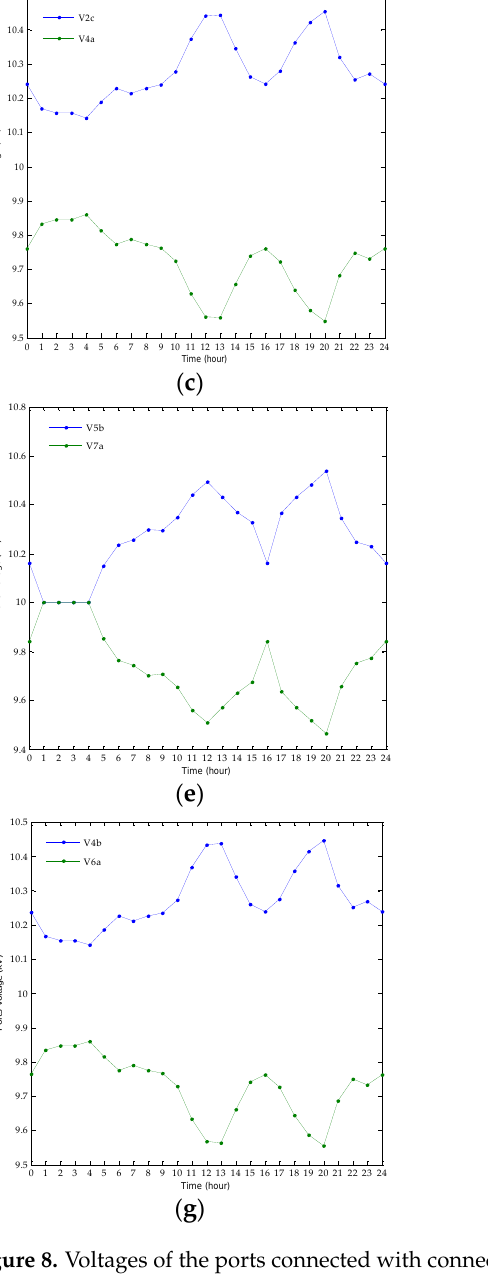
l ; ( c ) Voltage of both ends of  2 3 l ; ( e ) Voltage of both ends of  3 5 l ; ( g ) Voltage of both ends of  5 6 l .  6 7